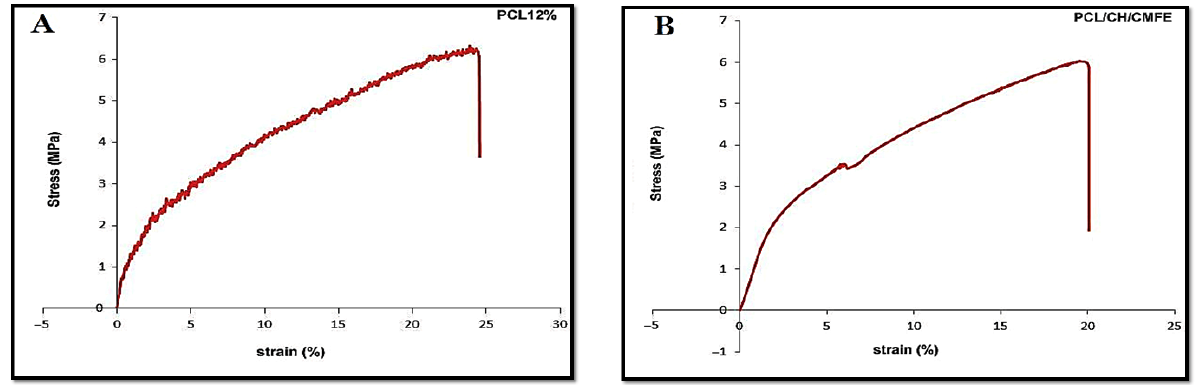
Figure 4. ( A ) Representative stress–strain curve of pure PCL ( B ) PCL/CH containing CMFE.